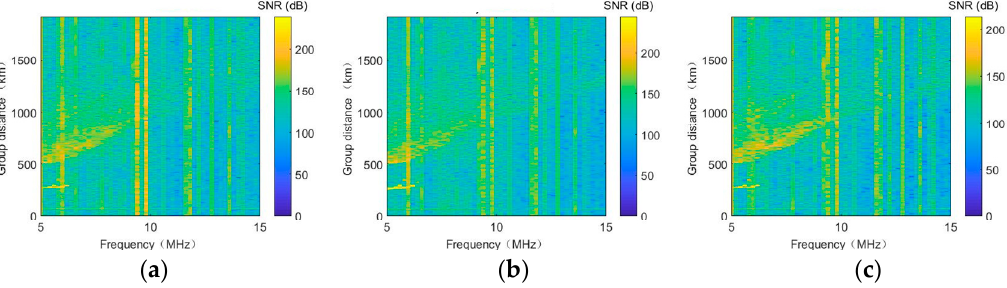
Figure 10. ( a ) The oblique backscatter ionogram of Channel 1; ( b ) The oblique backscatter ionogram of directly summing; ( c ) The oblique backscatter ionogram of digital beamforming (DBF).